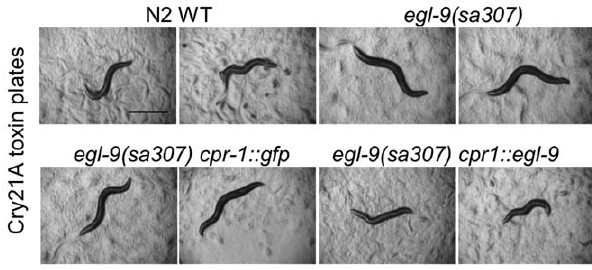
Figure 5. Intestinal specific expression of egl-9 is sufficient to rescue Cry21A PFT resistance. Resistance to Cry21A was compared among wild type N2, egl-9(sa307), egl-9(sa307) transformed with cpr- 1::gfp , and egl-9(sa307) animals transformed with cpr1::egl-9 . Two representative worms are shown for each strain 48 h after feeding on E. coli -expressed Cry21A. Wild-type animals and egl-9(sa307) animals transformed with cpr1::egl-9 are similarly sensitive to Cry21A whereas egl-9(sa307) animals and egl-9(sa307) animals transformed with cpr-